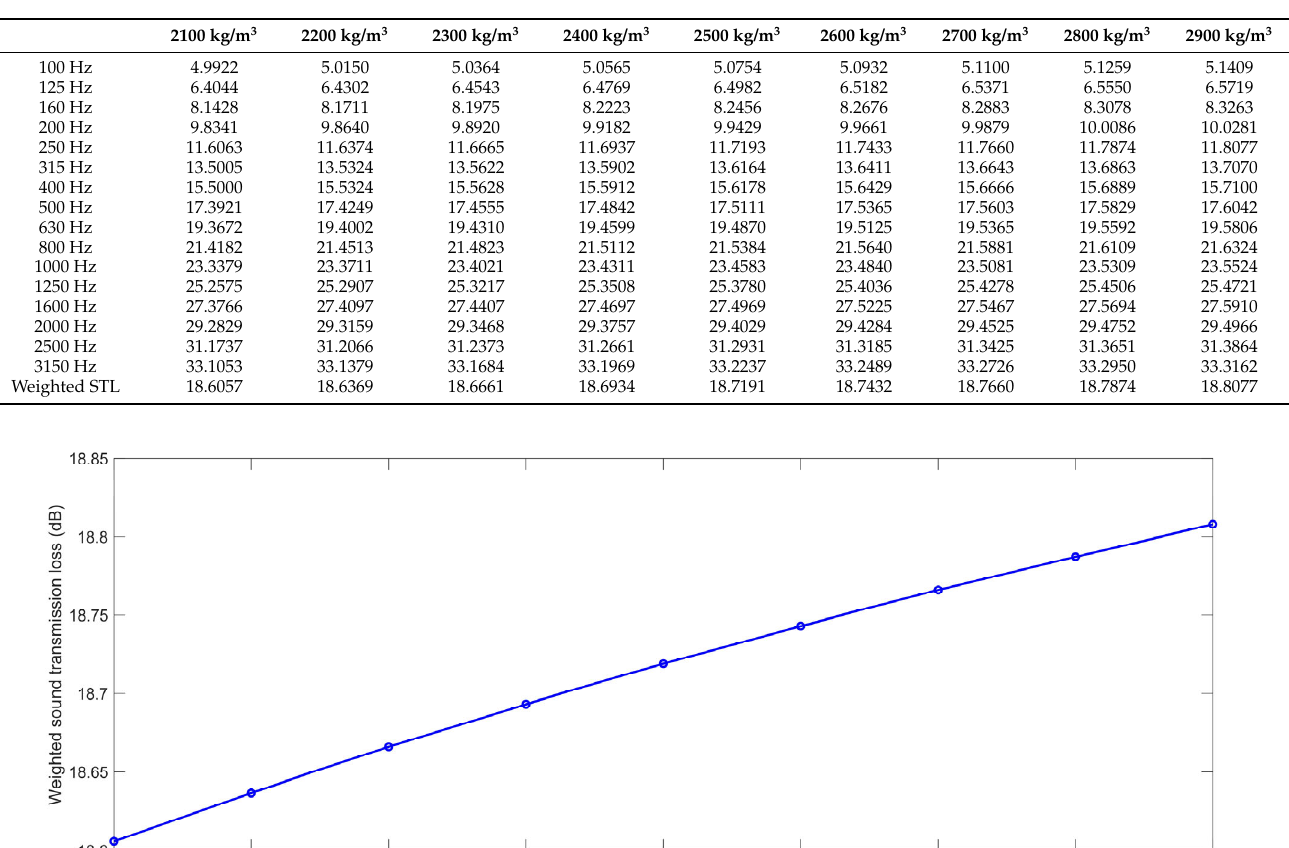
Table 8. The summarized STL data with the various density of the HGM.